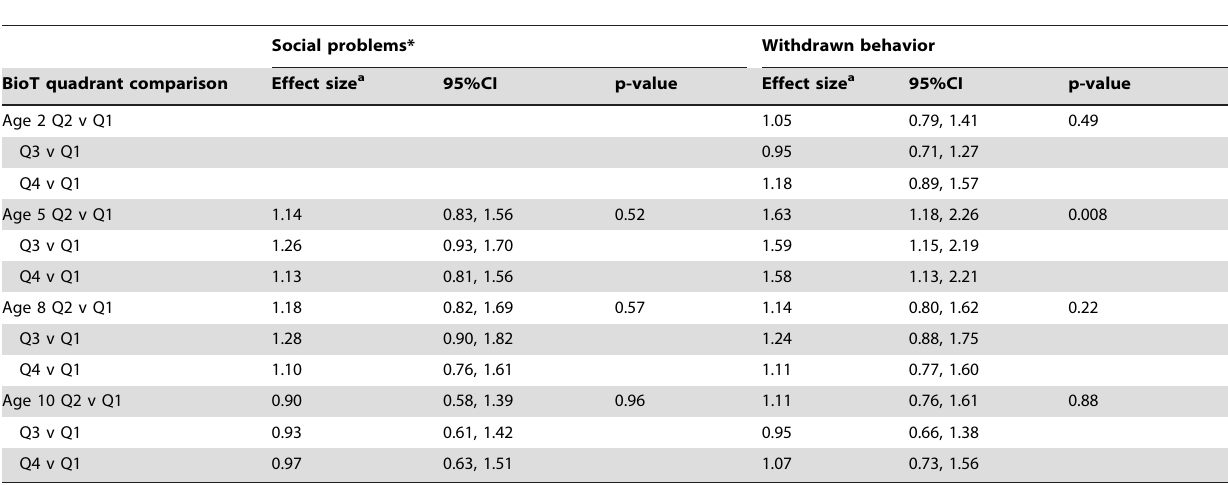
Table 5. Modeled effect of prenatal bioavailable testosterone (BioT) levels on raw syndrome scores-